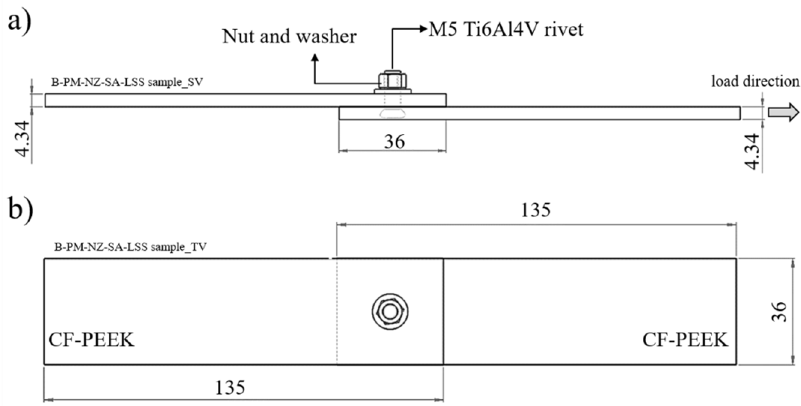
Figure 5. Schematic illustration of single lap shear specimen geometry along with the dimensions and load direction: specimen ( a ) side view and ( b ) top view. All dimensions are in millimeters.